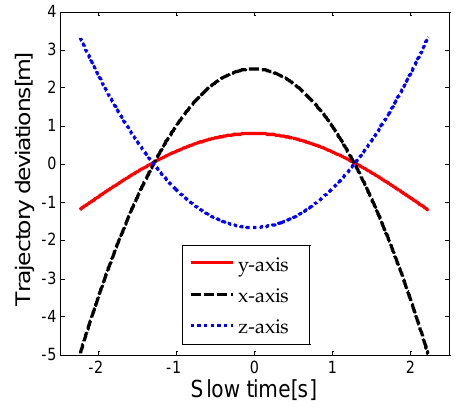
Figure 6. Trajectory deviations.